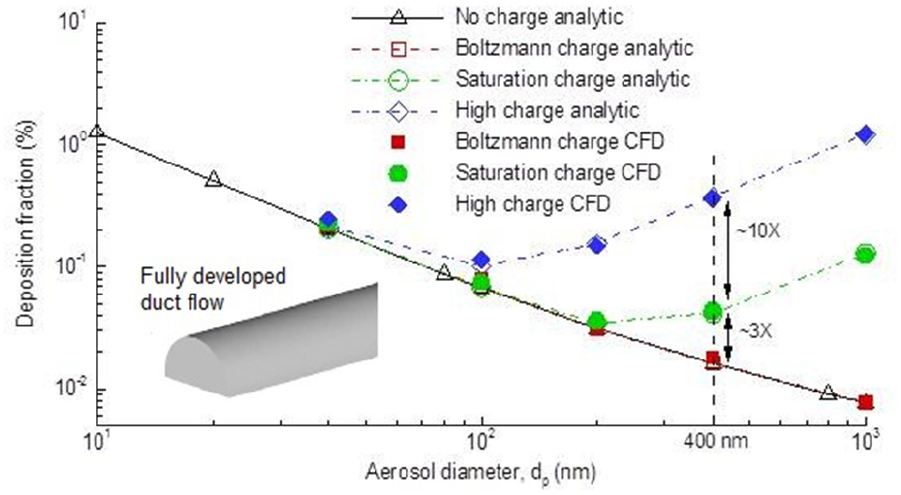
Figure 2. Comparison of numerically predicted aerosol deposition due to the image force with the analytic expression of Chen and Yu [11] for fully developed laminar flow in a tube.